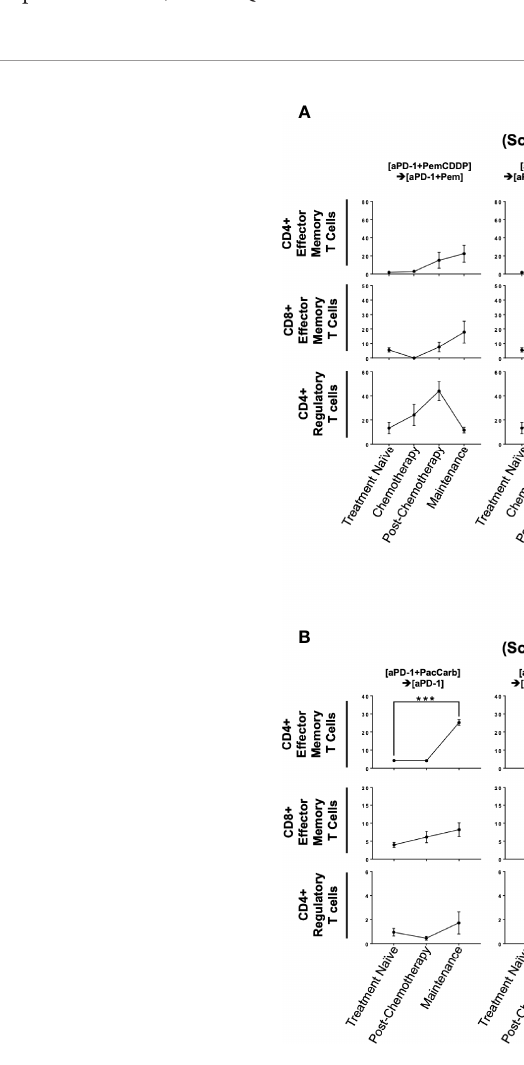
FIGURE 3 | SKI-G-801 treatment increases memory function of the immune system. Analysis of T cell subset of TC1 tumor model (A) and C3PQ tumor model (B) by fl ow cytometry. (A) The effector memory subset of CD4 + T cells was signi fi cantly increased in the maintenance state of the [aPD-1+PemCDDP] ! [SKI-G-801] group and the [aPD-1+PemCDDP+SKI-G-801] ! [aPD-1+Pem+SKI-G-801] group compared to the treatment naïve group. The effector memory subset of CD8 + T cells showed an increase and CD4 + regulatory T cells showed a decreasing trend after chemotherapy, but these results were not signi fi cant. (B) The effector memory subset of CD4 + T cells was signi fi cantly increased in the maintenance state of all groups compared to the treatment naïve group. In addition, the effector memory subset of CD8 + T cells was increased in the maintenance state of the [aPD-1+PacCarb] ! [aPD-1+SKI-G-801] group and the [aPD-1+PacCarb+SKI-G-801] ! [aPD-1+SKI-G-801] group compared to the treatment naïve group. CD4 + regulatory T cells showed no meaningful changes. (*p ≤ 0.05, ***p ≤